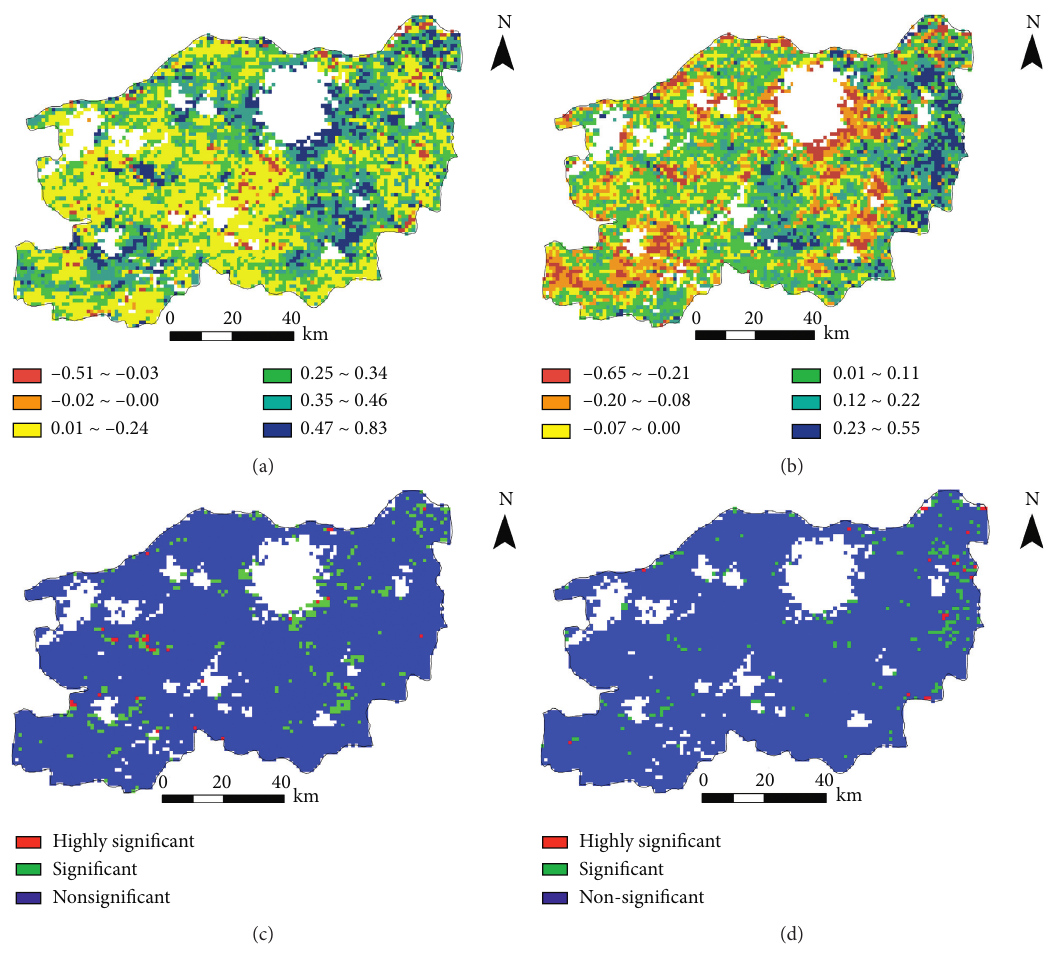
Figure 3: Correlation coefficients and significance tests between (a, c) NPP and precipitation and (b, d) NDVI and temperature. Highly significant, significant (+), and nonsignificant areas are shown in (c) and (d), where the positive correlations between NDVI and pre- cipitation and temperature are significant at the 99% and 95% confidence levels, and the nonsignificant positive and negative